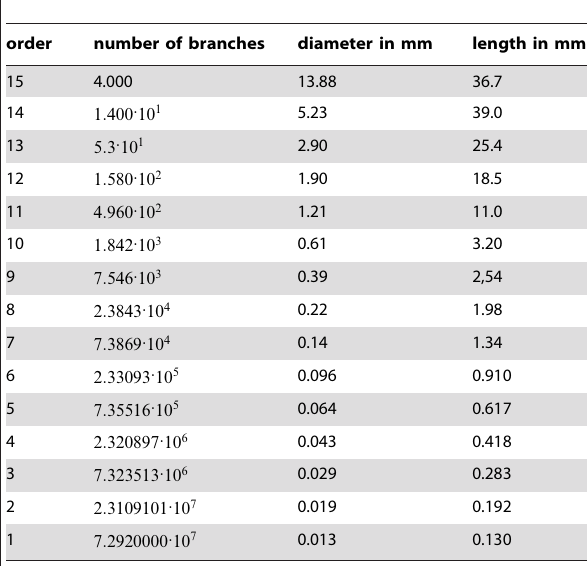
Table 2. Model of the pulmonary venous tree (according to